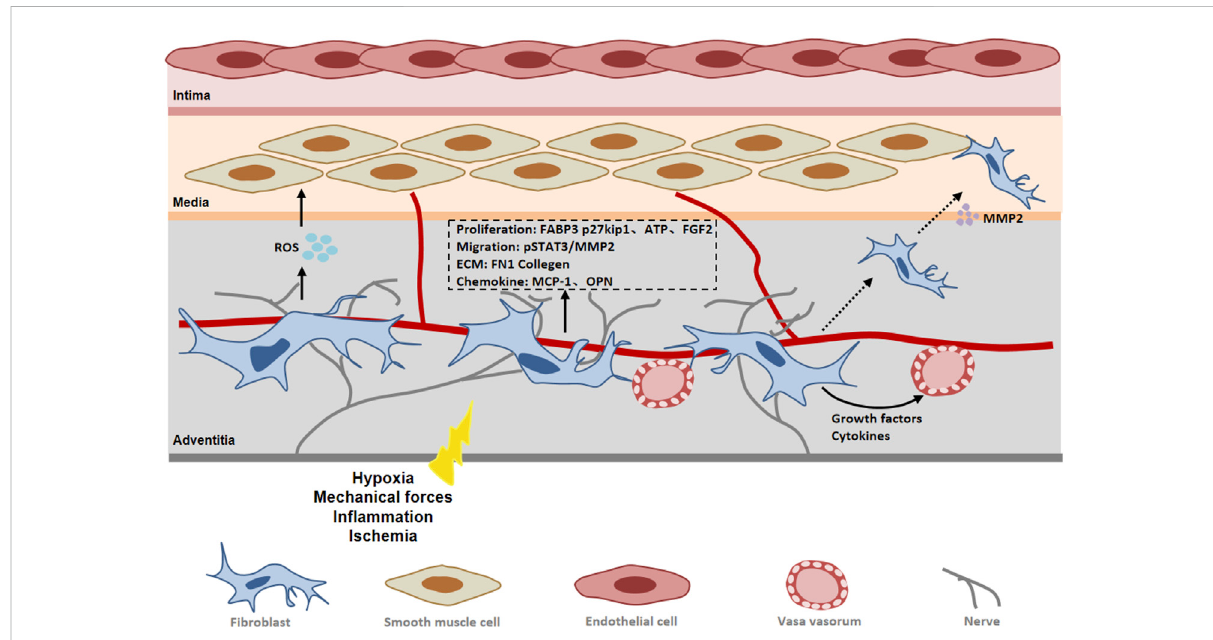
FIGURE 4 Theroleof fi broblastinperipheralarterialdisease(PAD).Inresponsetovascularinjury,adventitial fi broblastsbecomeactivatedanddifferentiate into myo fi broblasts. Fibroblasts contribute to vascular remodeling through proliferation, migration and extracellular matrix synthesis. Abbreviations: FGF2, fi broblast growth factor 2; FABP3, fatty acid binding protein 3; MMP2, matrix metalloproteinase 2; pSTAT3, phosphorylated signal transducer and activator of transcription 3; ROS, reactive oxygen species; FN 1, fi bronectin 1; OPN,